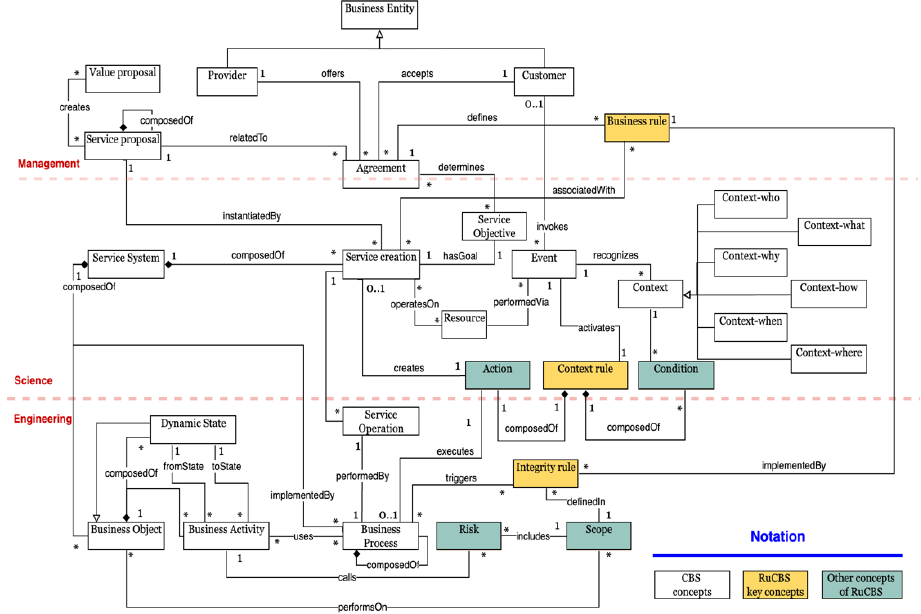
Fig. 1. RuCBS meta-model represented by UML